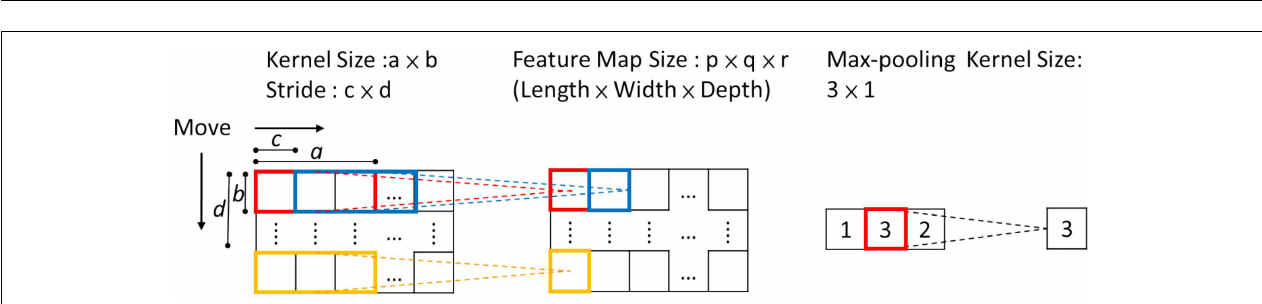
FIGURE 2 | The schematic diagram of the operation of convolution and pooling, as well as the resulted size of the feature